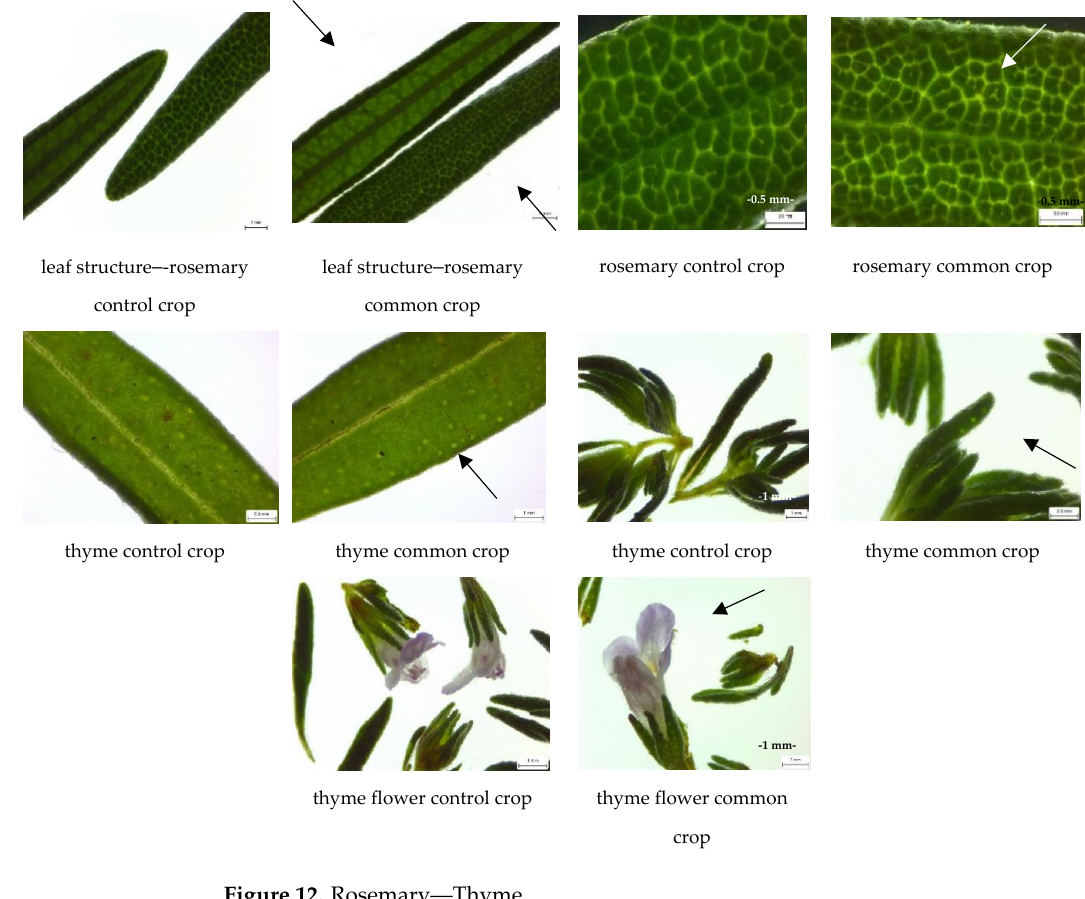
Figure 12. Rosemary — Thyme. Figure 12. The leaves and petals of St. John ’ s Wort flowers in the studied crop show a higher number of secretory bags with hypericin (expressed by an increased number of black dots located in the upper peripheral area), and lemon balm leaves have a visibly higher number of octocellular glandular hairs (Figure 13) compared to the control crop.